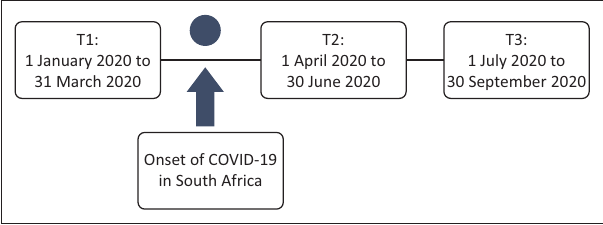
Figure 1 indicates the three periods of data gathering according to the pre-and post-lockdown, referred to as T1, T2 and